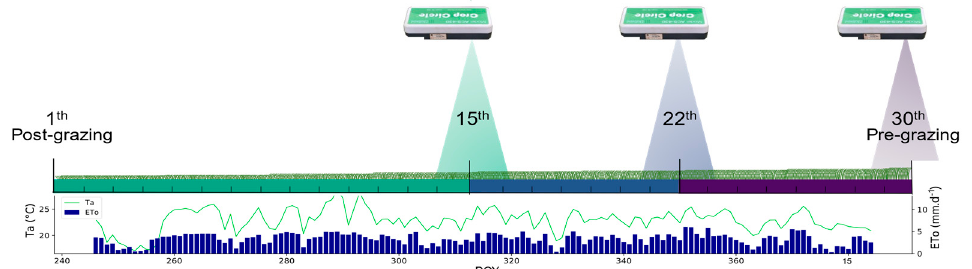
Figure 3. Schematic model of data collection, with the meteorological data collected daily and the spectral data at three moments of the cycle.